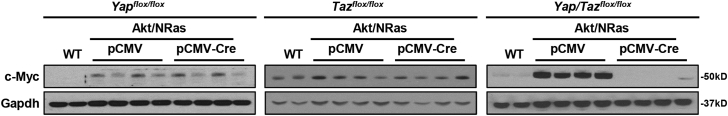
c-MYC is a potential target coordinately regulated by YAP and TAZ. Western blot results showing expression of c-Myc in Yapflox/flox, Tazflox/flox, and Yap/Tazflox/floxmurine Akt/NRas liver tumors. Glyceraldehyde-3-phosphate dehydrogenase (Gapdh) was used as a loading control.